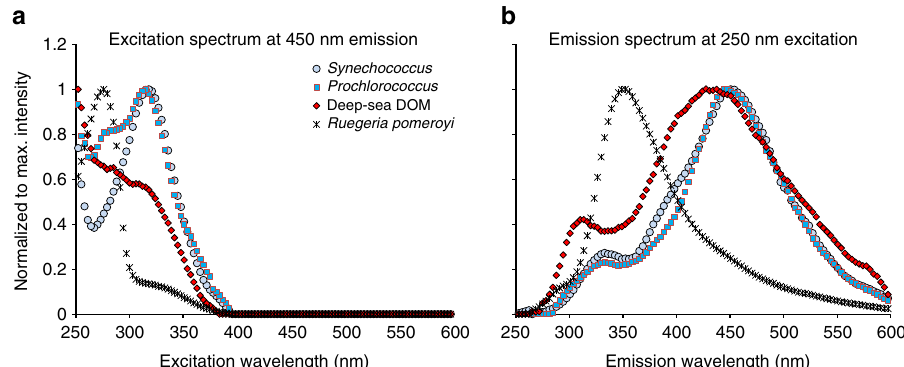
Figure 2 | Excitation and emission spectra of Synechococcus , marine and heterotrophic bacteria FDOM at the humic-like fluorescence maximum. Excitation and emission spectra, normalized to highest intensities of SPE-DOM, in pure water at maximum humic-like fluorescence at ( a ) excitation: 250nm and ( b ) emission: 450nm.